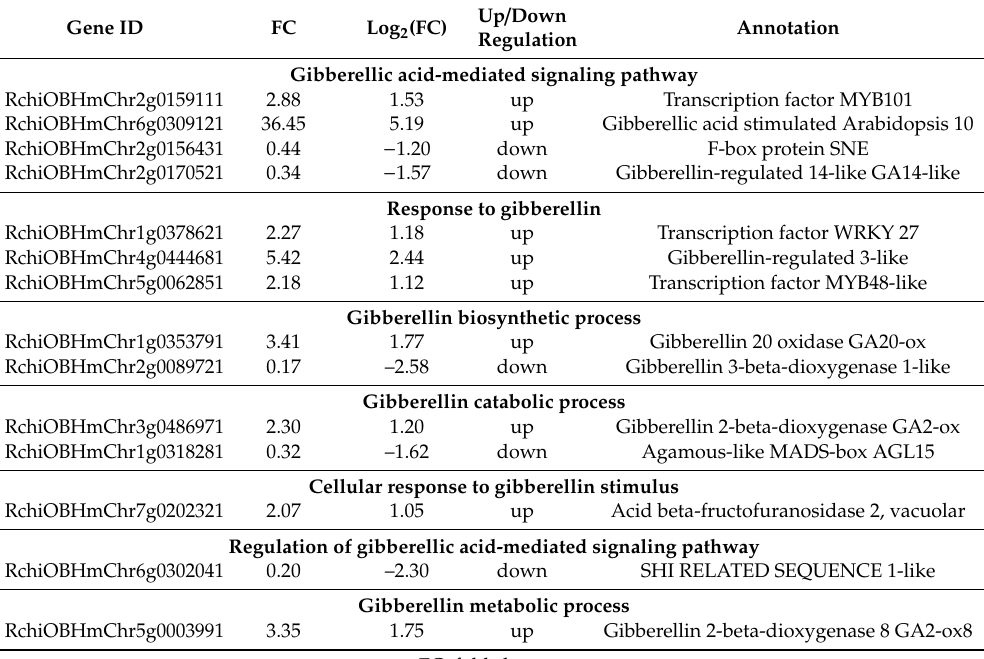
Table 3. DEGs involved in the gibberellin signaling pathway.